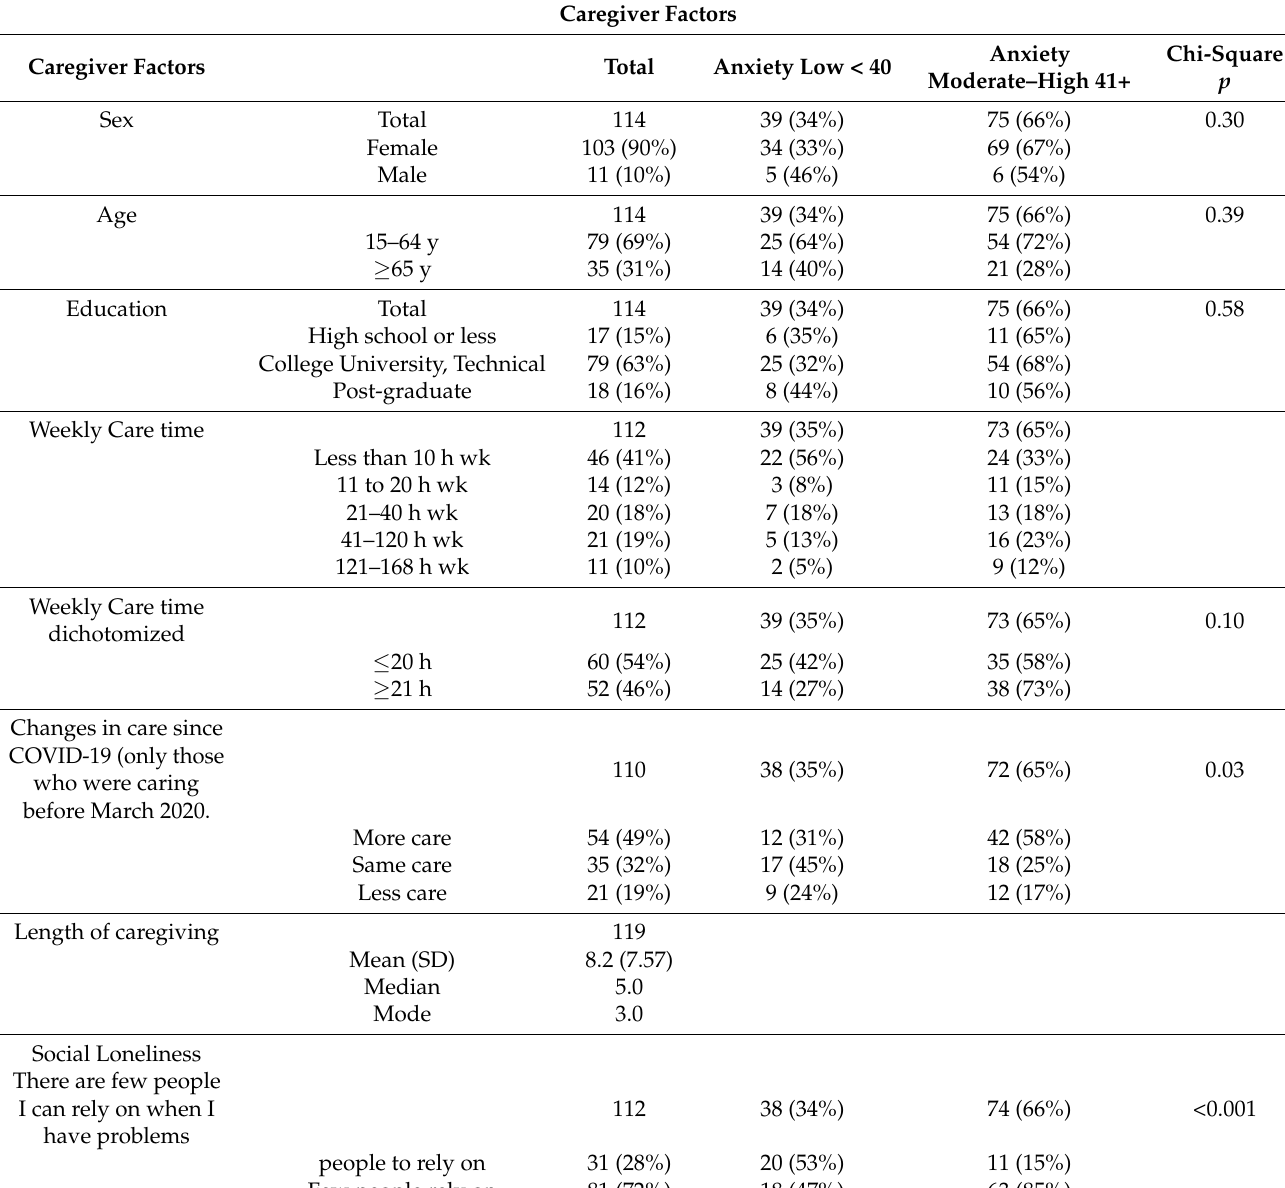
Table 2. Survey demographics by high and low